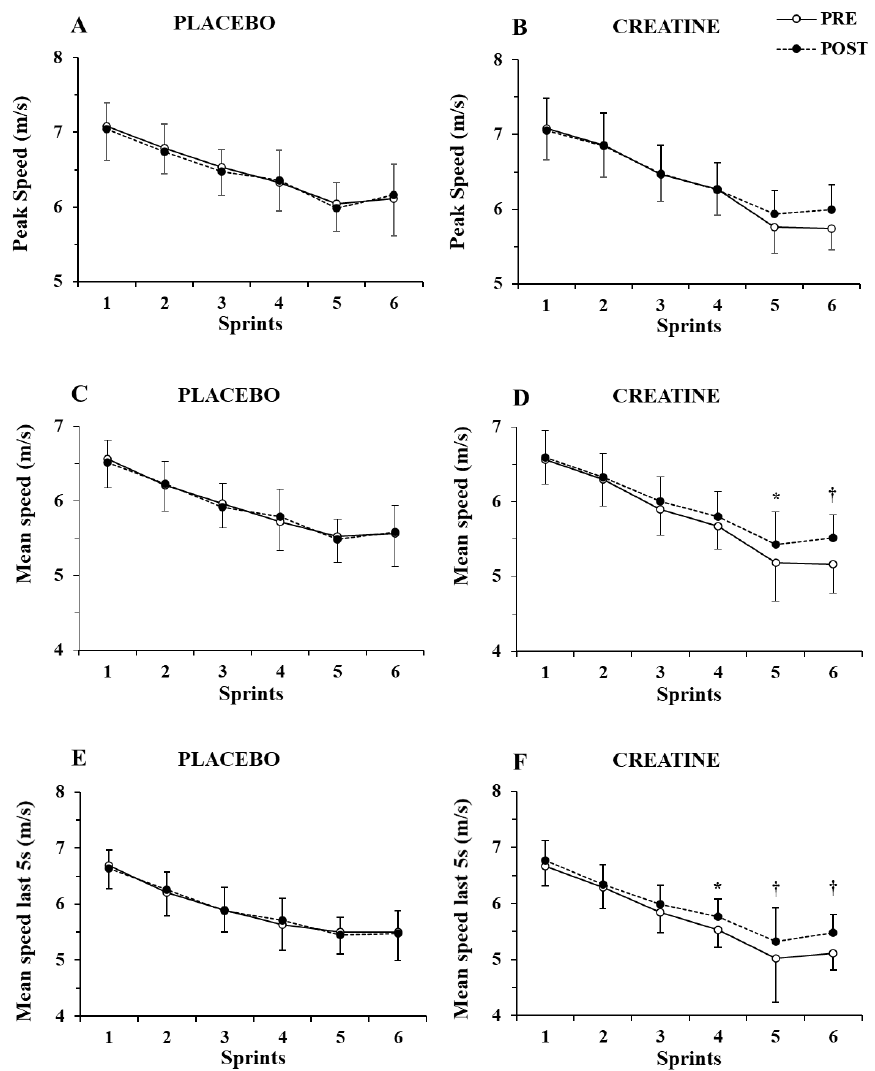
Figure 3. Peak speed ( A , B ) and mean speed during the first ( C , D ) and last 5 sec ( E , F ) of each sprint for the placebo and creatine groups pre- and post-supplementation. * p < 0.01; † p < 0.001 pre- vs. post-creatine supplementation.